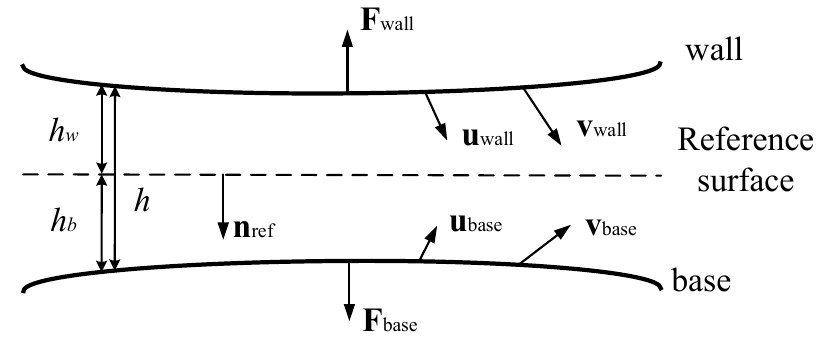
Figure 5. Schematic diagram of the squeeze film damping distribution in the 1/4 solution domain: red and yellow lines indicate squeeze film damping between the sidewalls of the back of the main arm of the driving electrode and between the shutters and the sensing strips, respectively.